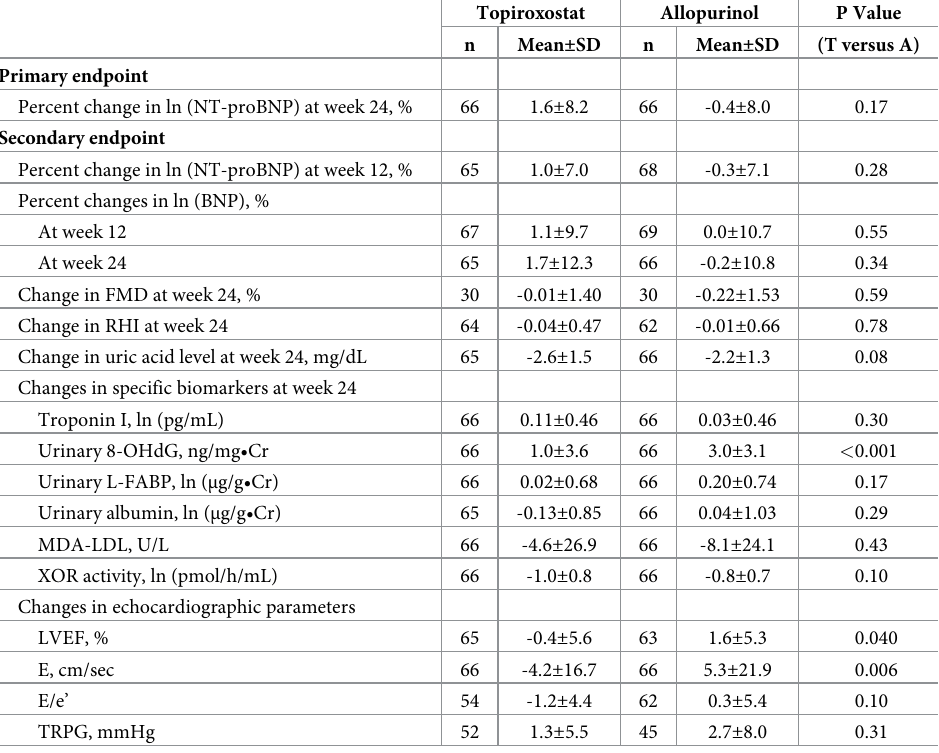
Values are mean ± standard deviation. P values are analyzed for differences between the two groups by the unpaired